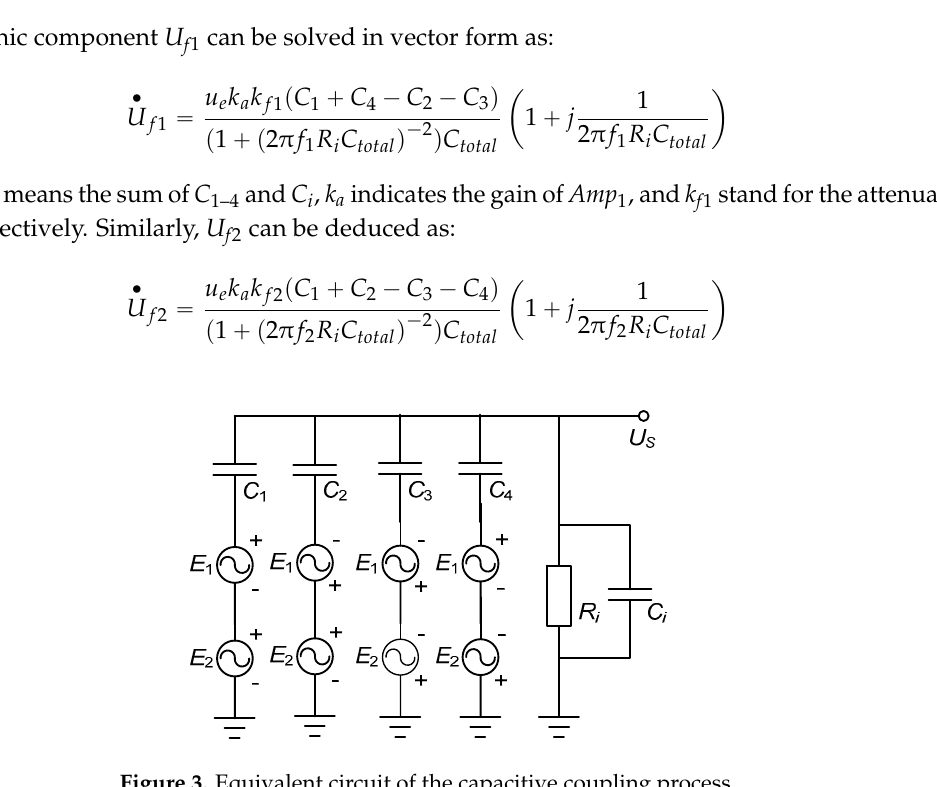
Figure 3. Equivalent circuit of the capacitive coupling process.